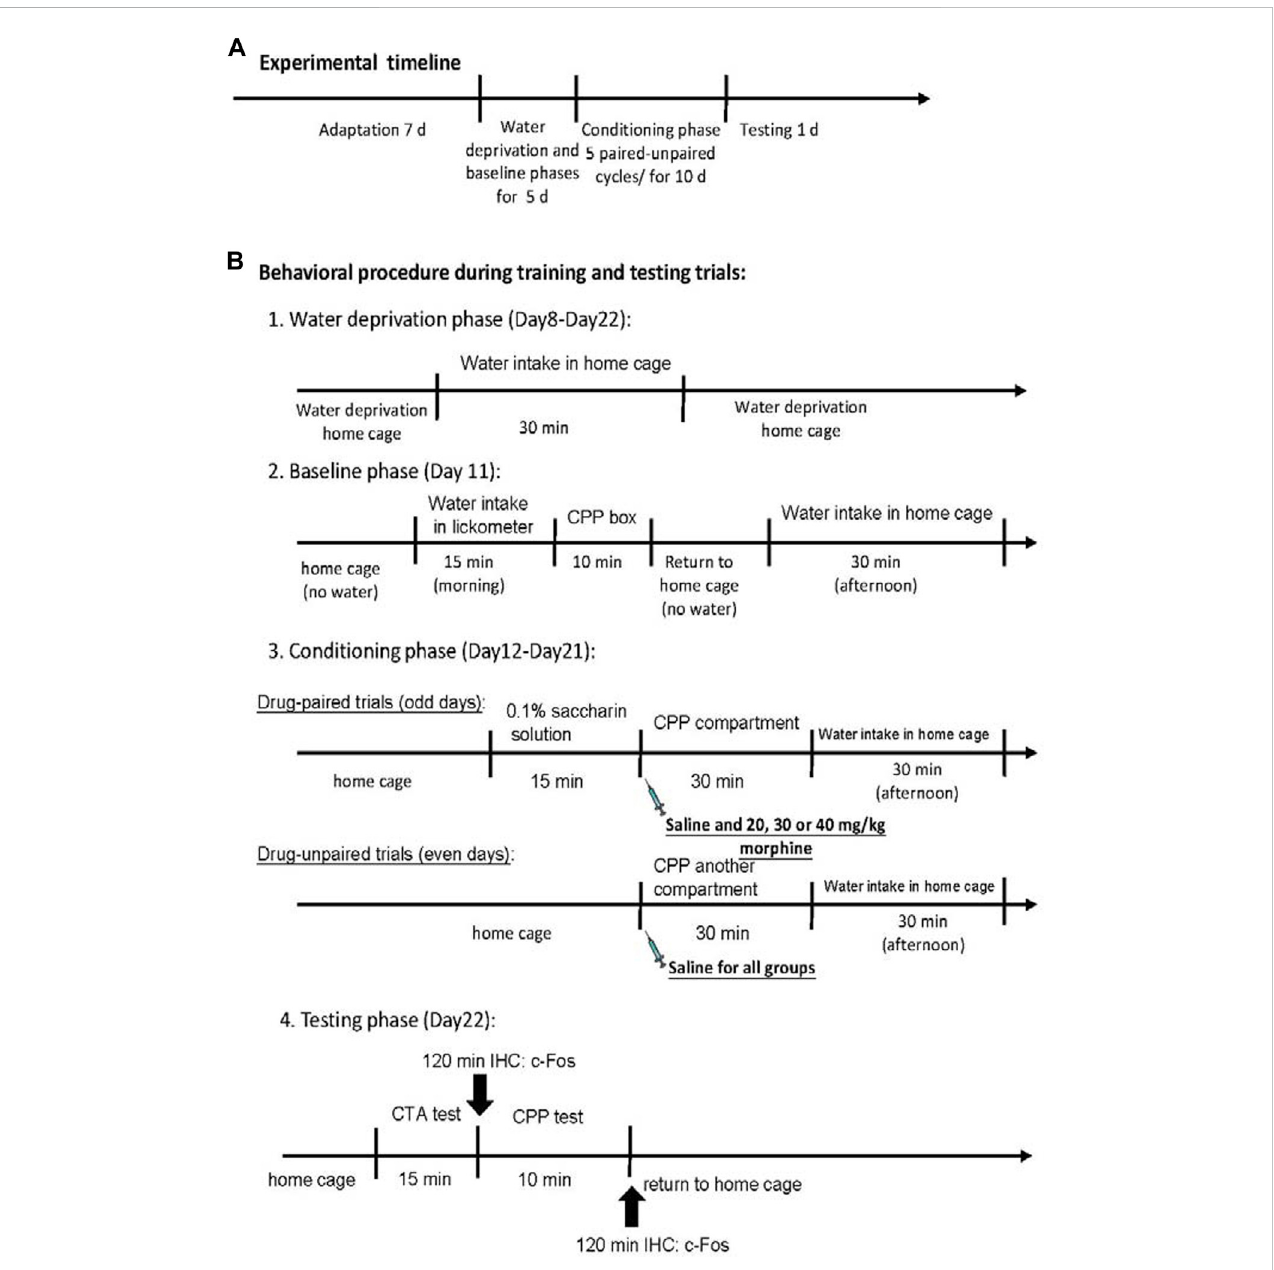
FIGURE 2 Overview of the experimental procedures. (A) The whole experimental timeline. (B) Details of behavioral procedure during training and testing